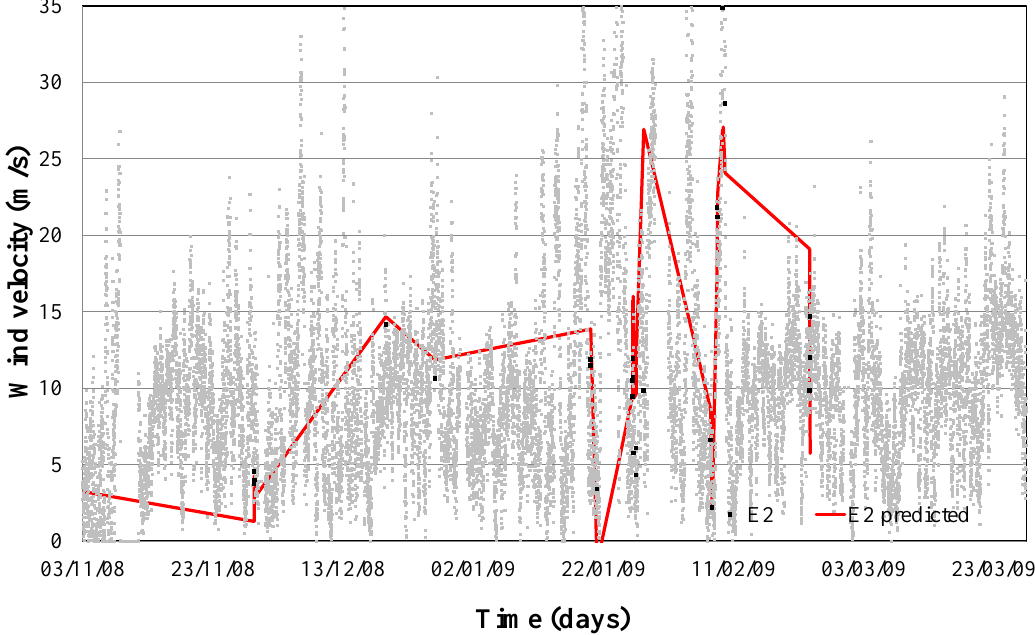
Figure 6. Validation error 2 prediction model.